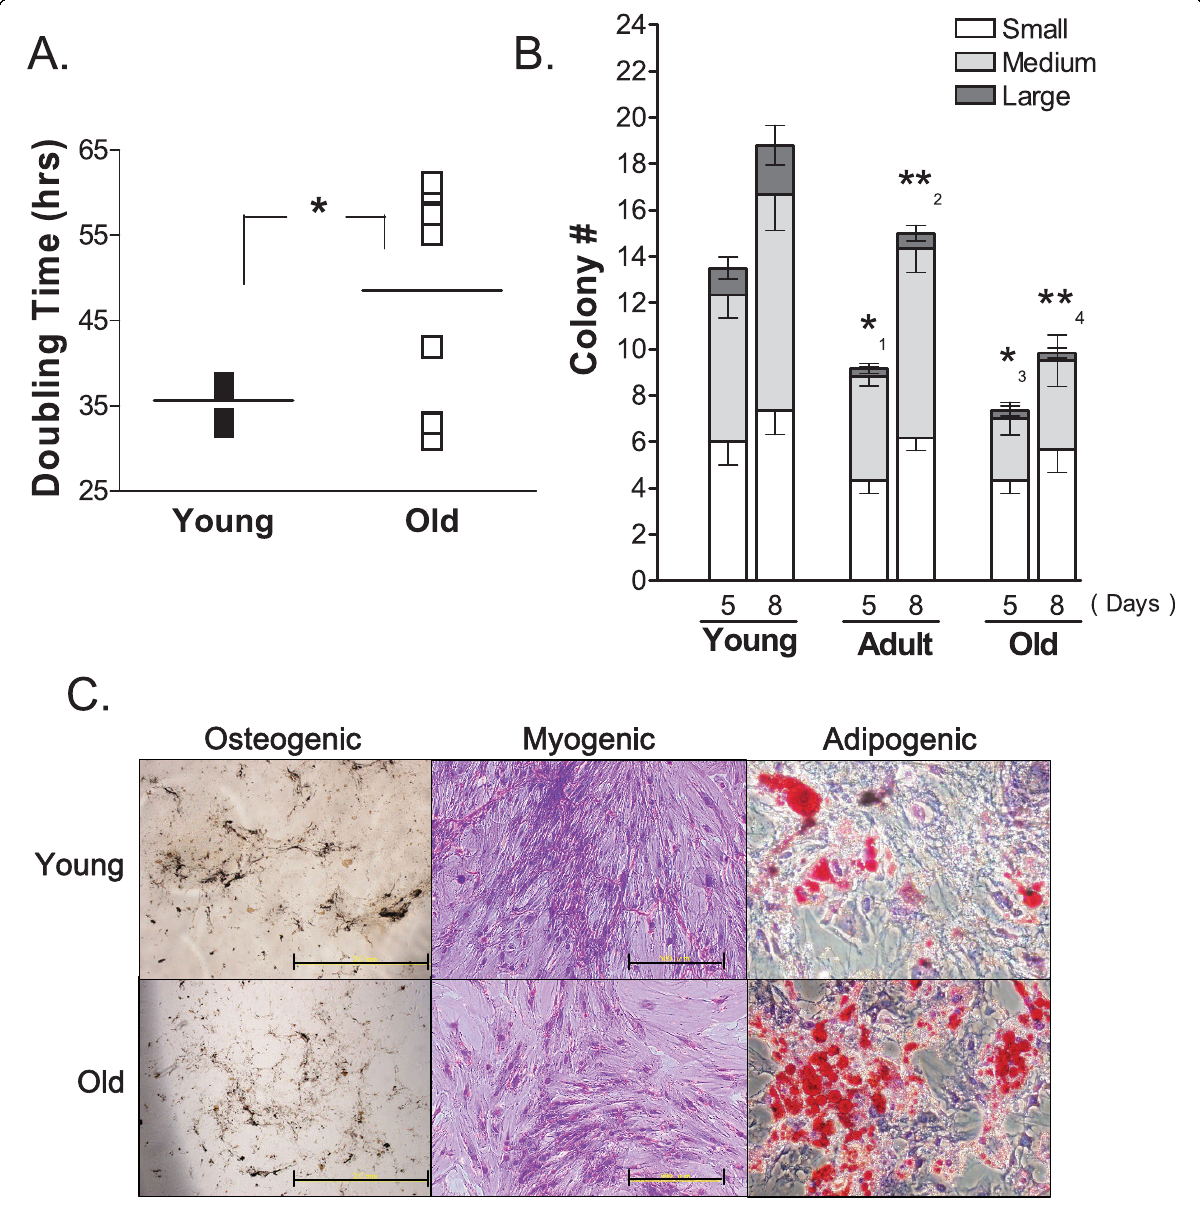
Figure 1 Renewal and differentiation capacity of ADSCs from old, adult, and young mice . A . Doubling time of P0 ADSCs. *: P < 0.04, N = 5 for young ADSCs, N = 7 for old ADSCs. B . Number of small (5-10 cells/colony), medium (10-50 cells/colony), and large (> 50 cells/colony) colonies formed after 5 or 8 days of culture after initially plating 5000 young, adult, or old P0 ADSCs. Young ADSCs formed significantly more large colonies than either adult or old ADSCs. * 1 : P < 0.04; ** 2 : P < 0.006 between adult and young ADSCs for the 5- and 8-day colonies; * 3 : P < 0.02; ** 4 : P < 0.004 between old and young ADSCs for the 5- and 8-day colonies. ADSCs from the same mouse were plated in triplicates. N = 8. C . Osteogenic (von Kossa staining), myogenic (Liu ’ s staining), and adipogenic (Oil-Red O staining) differentiation in young and old P1 ADSCs responding to differentiating medium after 21 days. The scale bars are 2.0 mm (von Kossa) and 500 μ m (Liu ’